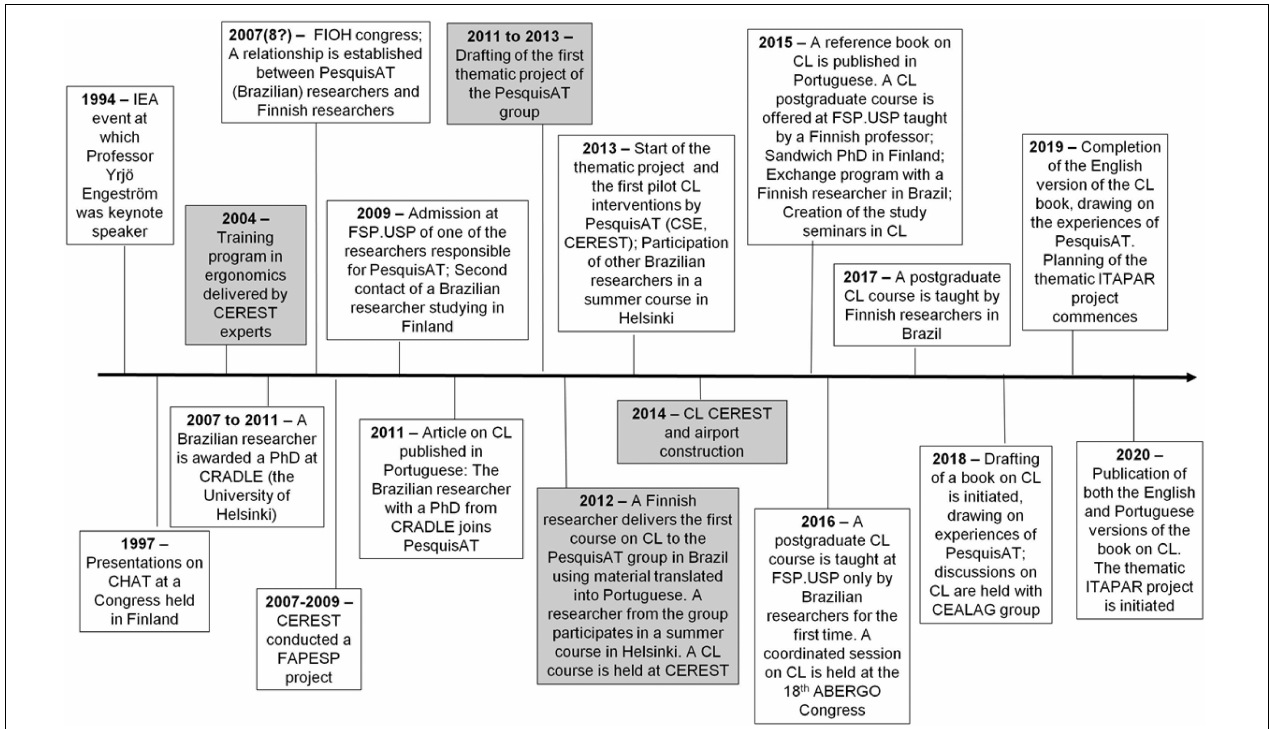
FIGURE 2 | Timeline of critical events pertaining to the consolidation of PesquisAT. Critical events for PesquisAT are shaded gray. IEA, International Ergonomics Association; CHAT, Cultural-Historical Activity Theory; CEREST, Workers’ Health Reference Centre; CRADLE, Centre for Research on Activity, Development and Learning; FIOH, Finnish Institute of Occupational Health; FAPESP, São Paulo Research Foundation; FSP.USP, School of Public Health, University of São Paulo; CL, Change Laboratory; CSE, School Health Centre; ABERGO, Brazilian Ergonomics Association; CEALAG (CEALAG is a non-profit civil association founded